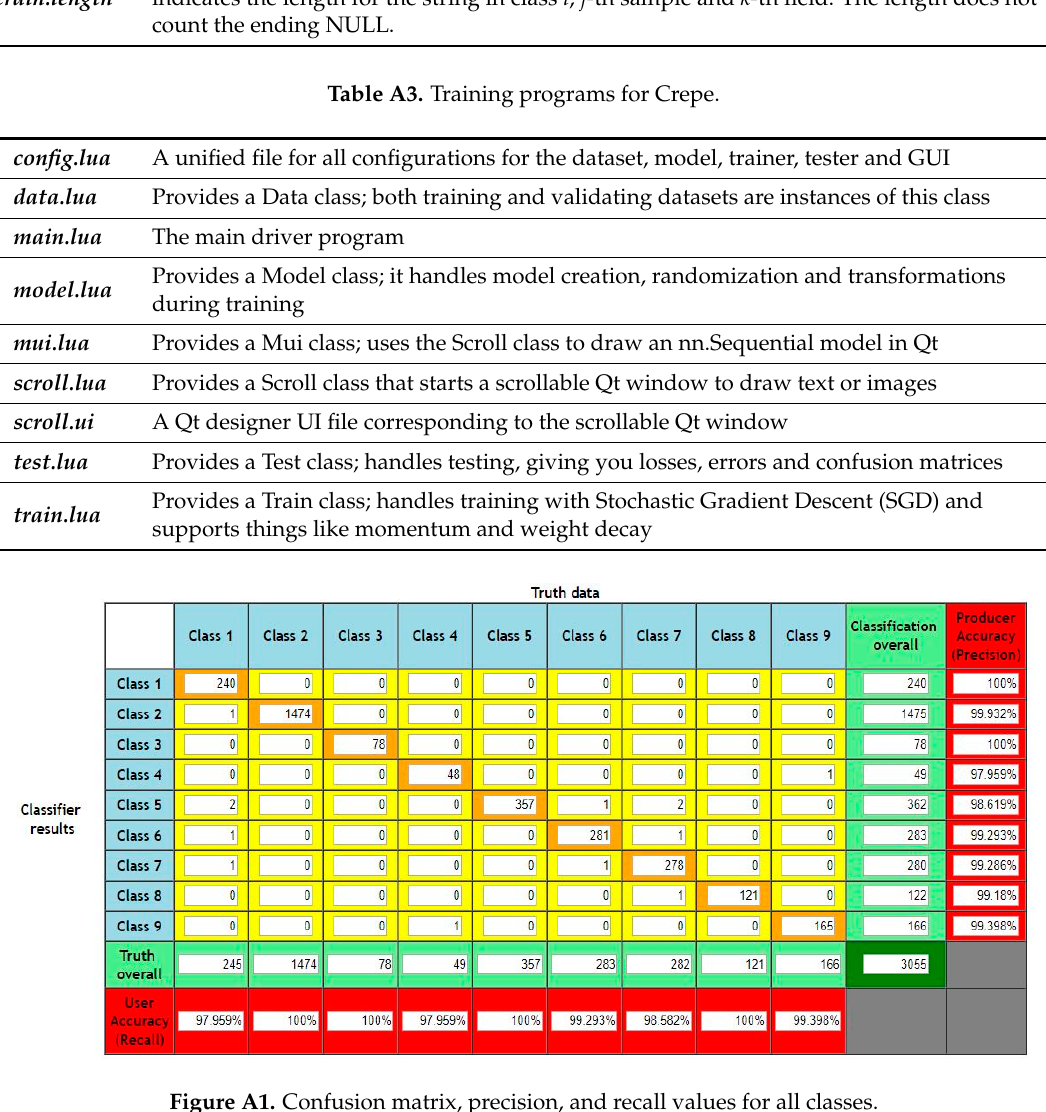
Table A3. Training programs for Crepe.